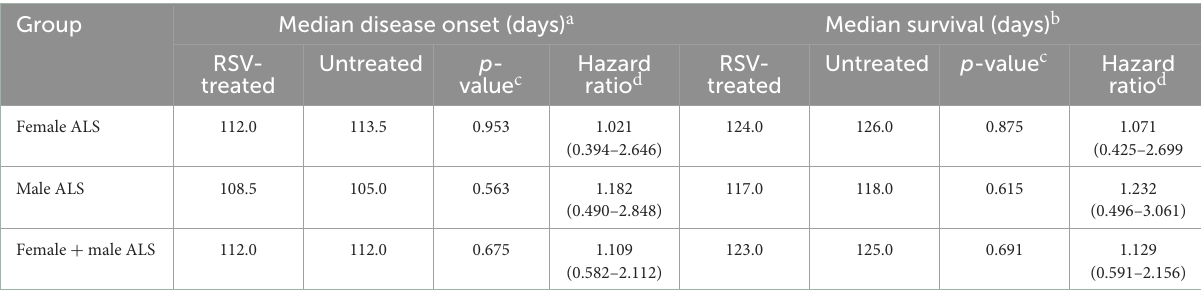
TABLE 1 Median disease onset and median survival of RSV-treated and untreated ALS mice.